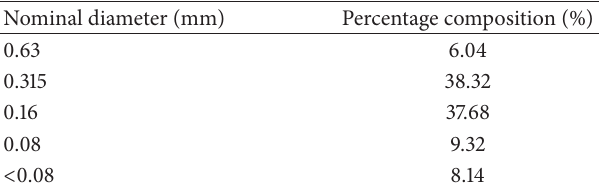
Table 2: Tailings sizes obtained from the Lixi tailings dam.